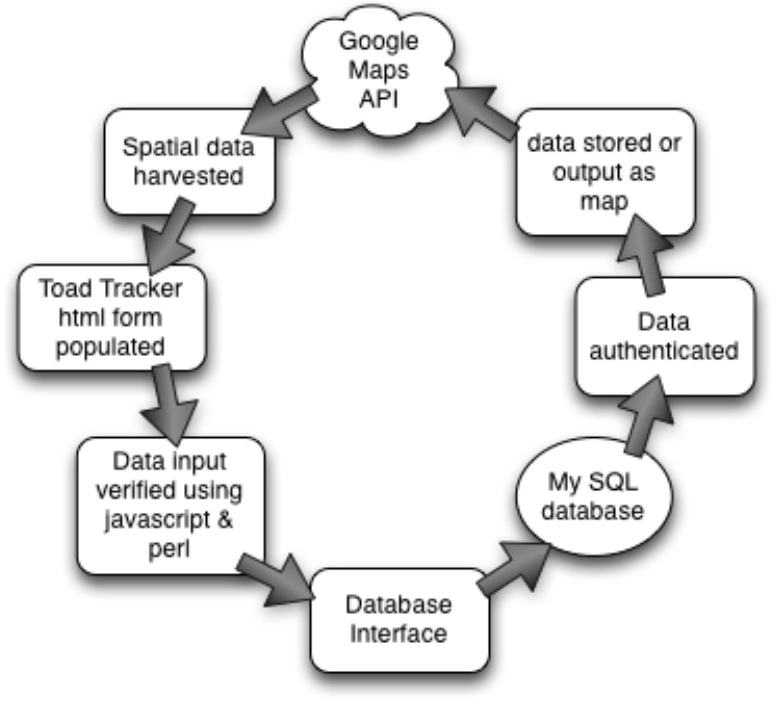
Figure 2. Outline of the Toad Tracker development sequence and data